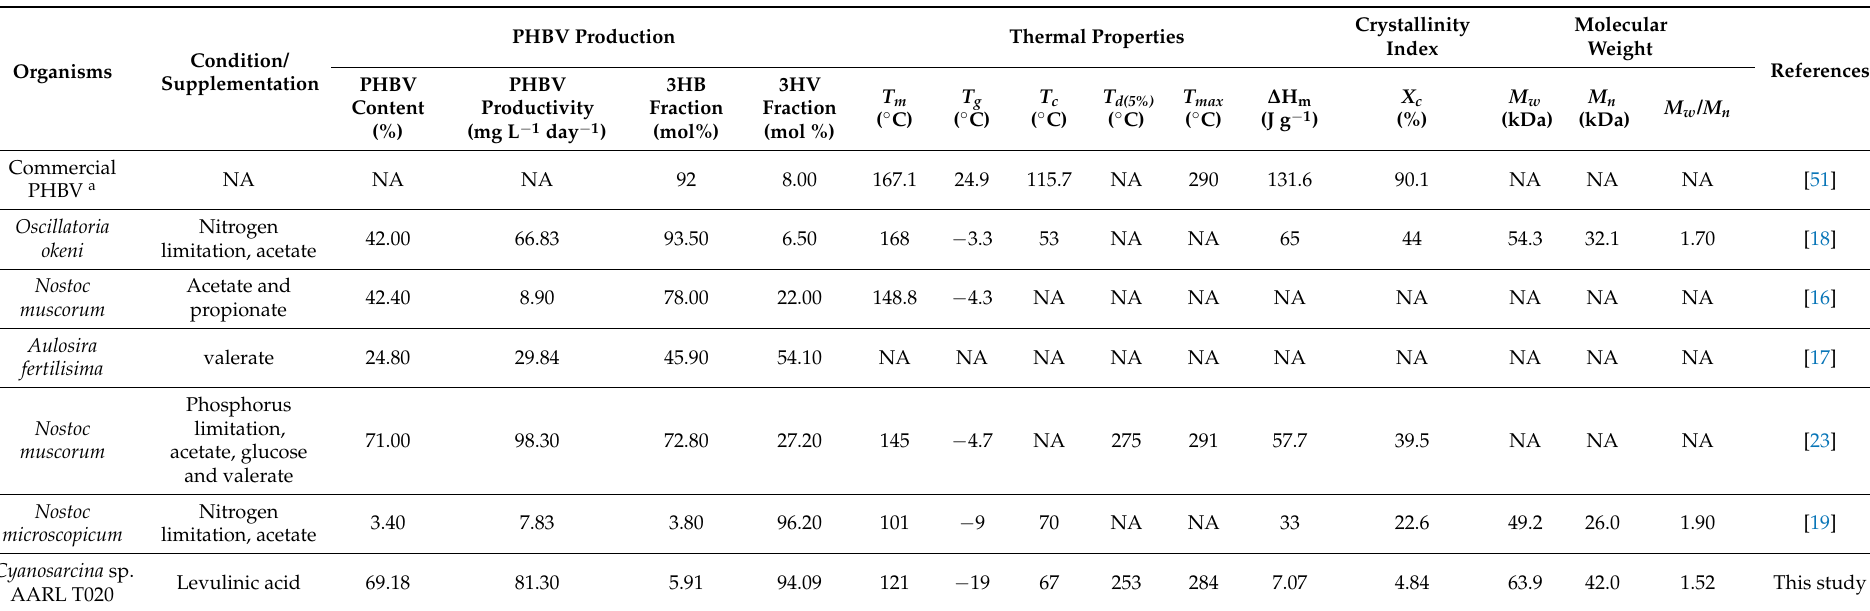
Table 5. PHBV productions in various organisms under different cultural conditions; Tm , melting temperature; Tg , glass transition temperature; Tc , thermal crystallization temperature; T d(5%) , the temperature at 5% weight loss; Tmax , the maximum degradation temperature; ∆ Hm , melting enthalpy; Xc , degree of crystallinity; Mw , weight-average molecular weight; Mn , weight-average molecular